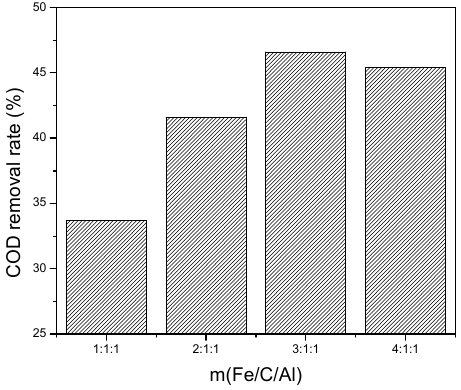
Figure 4. Influence of m(Fe/C/Al) on the COD removal rate.